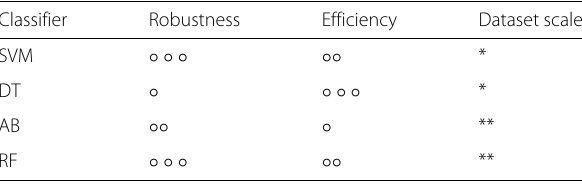
Table 2 Comparison of the four classification algorithms